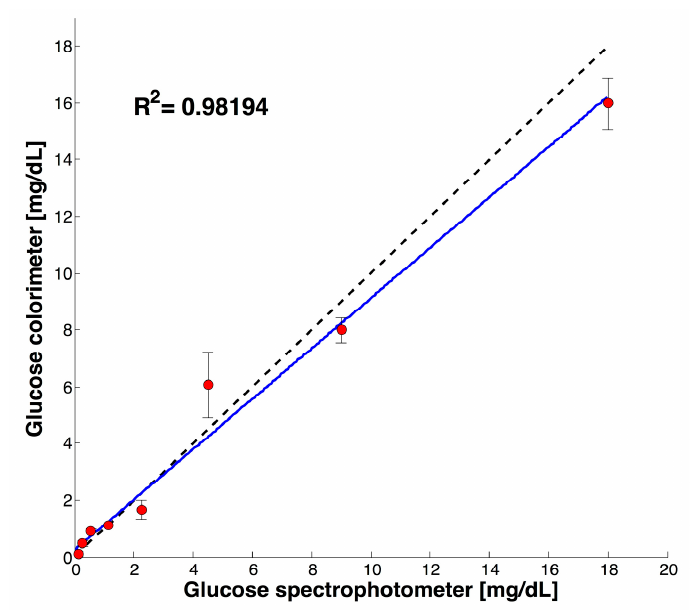
Figure 3. Validation of the developed colorimeter against the commercial spectrophotometer. Table 2. Validation of samples with the reference